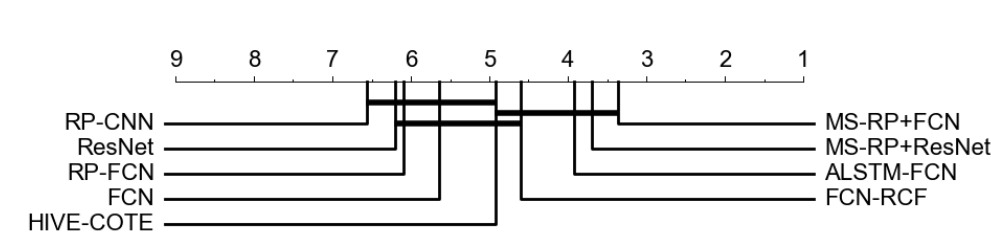
Figure 8. The CD diagram of the competitive approaches and our proposed two classifiers over 45 UCR datasets; the thick horizontal lines in the diagram indicate a cluster of classifiers that are not significantly different in terms of classification performance.